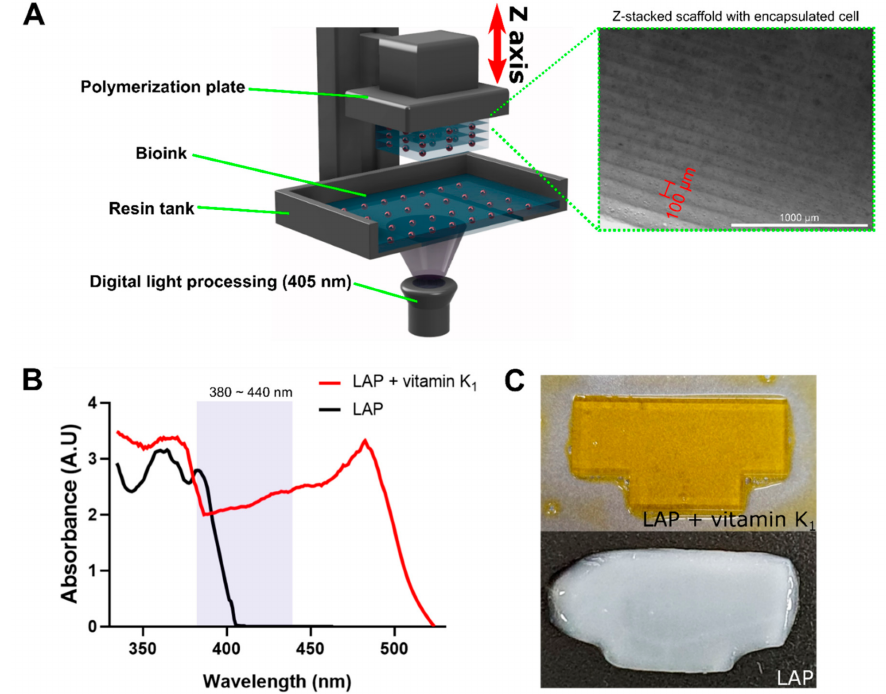
Figure 2. ( A ) Schematic describing the Z-stack bioprinting process for fabricating structures using bioink. LED light illuminates the resin tank from below, causing the resin to build up in units of 100 µ m under the polymerization plate while inducing photo-crosslinking. ( B ) Absorbance spectra of only photoinitiator (LAP) and a mixture of photoinitiator and photo-absorber (LAP + vitamin K 1 ). The shaded rectangular area is the LED wavelength range of the Z-stack bioprinter (380~440 nm). ( C ) Printing results using a combination of photoinitiator and photoabsorber (yellow, top) and only photoinitiator (white,